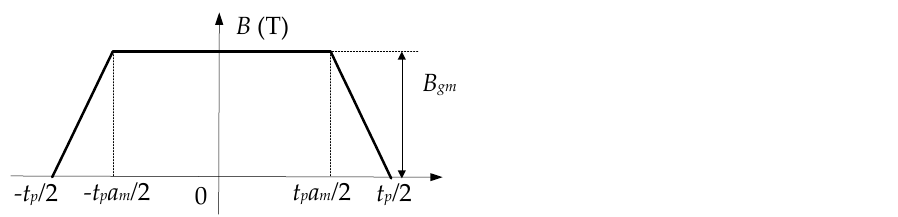
( d ) Figure 6. No-load air-gap flux density distribution of the four typical PMECCs: ( a ) Model − A; ( b ) Model − B; ( c ) Model − C; ( d ) Model − D. 3.2. On-Load Magnetic Field of Non-Slotted Conductor Rotor (CR) Based on the eddy current induction principle of PMECC with non-slotted CR, the eddy current generated in the CS mainly depends on the total magnetic flux looped with the PMR and CR. It has little to do with the small fluctuation of the air-gap flux density waveform. According to the analysis of the no-load air-gap flux density distribution of model − A and model − B, the half-period air-gap flux density waveform is equivalent to the standard trapezoidal wave shown in Figure 7. In this way, the calculation process of electromagnetic parameters such as eddy current field, CR copper loss and output torque under load state can be simplified greatly [10,12]. The air-gap flux density can be expressed by a piecewise function as: